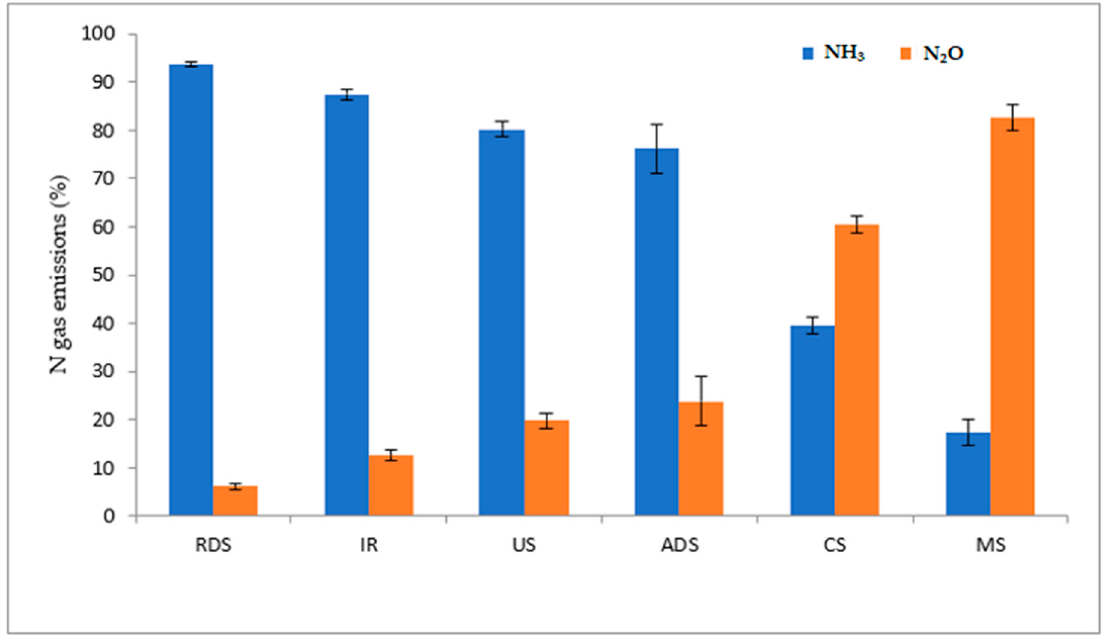
Figure 5. Contribution of NH 3 and N 2 O to total N gas emissions (%). Vertical bars represent the standard error of the mean (mean = 3).